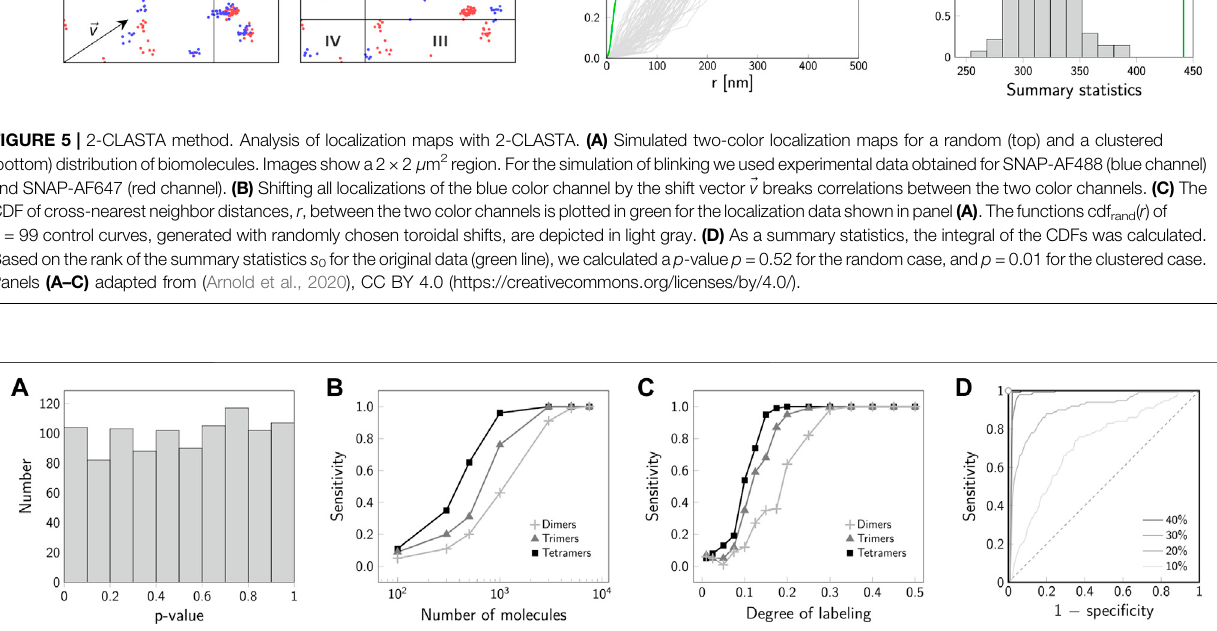
FIGURE 6 | Speci fi city and sensitivity of 2-CLASTA. (A) Speci fi city. The histogram of p -values shows a uniform distribution under the null hypothesis of a random biomolecular distribution. (B) Sensitivity for a varying number of observed molecules. Results are shown for simulations of dimers ( + ), trimers ( ▲ ) and tetramers ( ■ ). The sensitivityincreaseswithaincreasingnumberofobservedmolecules. (C) Sensitivityforvaryingdegreeoflabeling.Resultsareshownforsimulationsofdimers( + ),trimers ( ▲ )andtetramers( ■ ).Foradegreeoflabelingabove30 % ,maximumsensitivitycanbeachieved. (D) ROCcurvesareplottedforsimulationsofdimerswithadegree of labeling varying from 10 % (light gray) to40 % (black).With increasing degree of labeling the discrimination power of the test increases,i.e., the ROC curve approaches the point of perfect classi fi cation in the top left corner. The gray dashed line indicates the line of no discrimination. The sensitivity for each parameter set was determined based on 100 independent simulations. Panels (A – C) adapted from (Arnold et al., 2020), CC BY 4.0